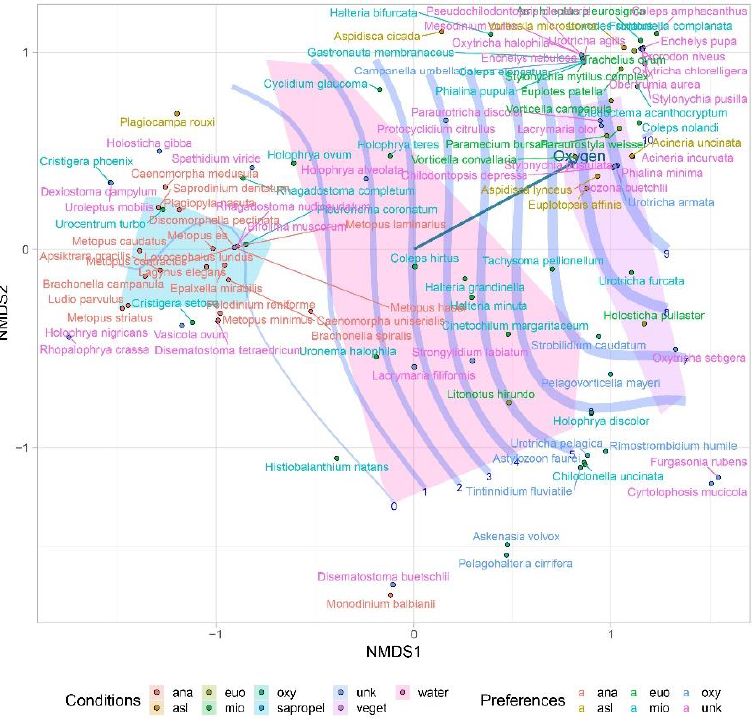
Figure 10. NMDS of habitats based on the abundance of ciliates with superimposed oxygen gradient (isolines whose width is proportional to the O 2 concentration indicated next to the isoline). Areas occupied by samples belonging to one of the three habitats—sapropel, water, and plants—are marked in color.